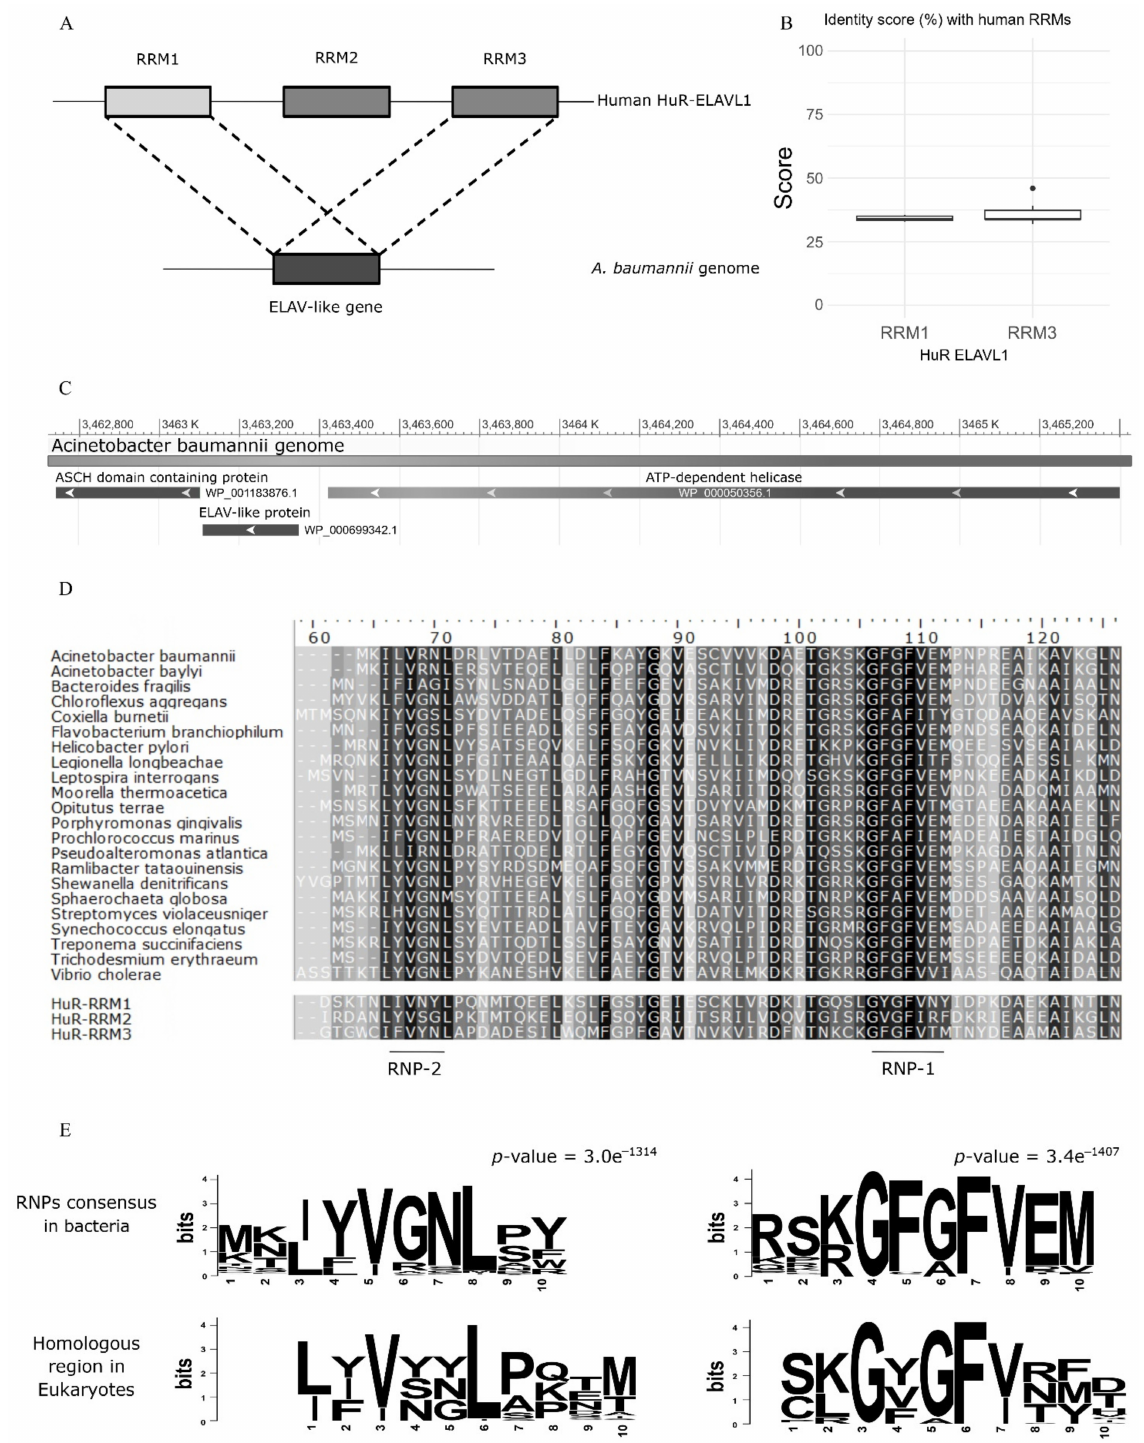
Figure 1. In silico analysis. ( A ) The tblastn search, using as query the human HuR and restricting the search to A. baumannii genomes, gave 25 hits corresponding to the same orthologous protein which share a high homology with both RRM1 and RRM3. ( B ) Boxplots showing the percentages of identity with the two RRMs, see Table S1 tblastn for the extended dataset. ( C ) Genomic context of the bacterial HuR, it is shown that the three genes, namely an ATP-dependent helicase, the AB- Elavl and the ASCH domain containing protein are arranged in proximity. ( D ) Alignment of the bacterial homologues of human ELAV in selected bacterial species with clinical or environmental